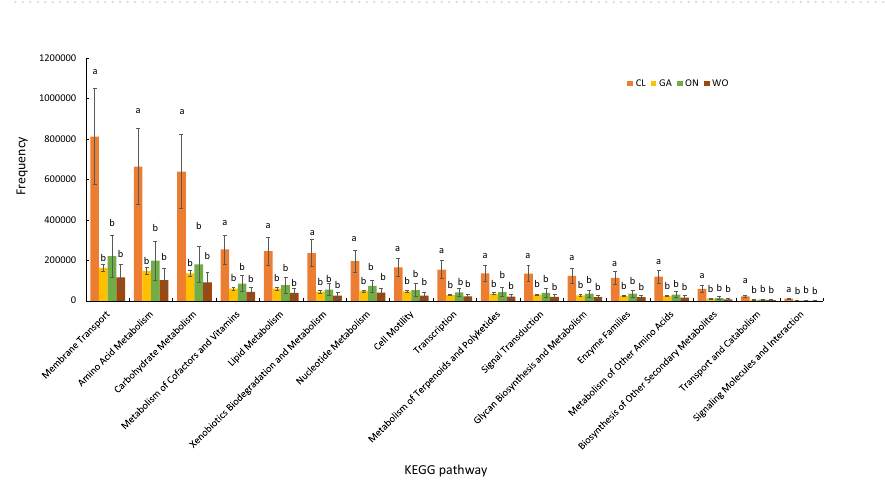
Figure 7. KEGG pathways with significant differences among the four Allium species. CL: Chinese leek; WO: Welsh onion; GA: Garlic; ON: